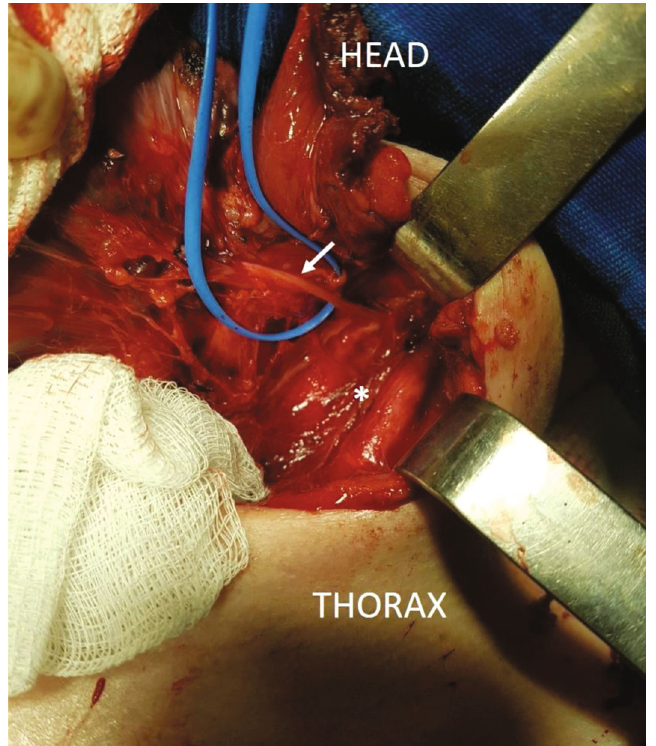
Figure 3: Dissection of the path of the left laryngeal nerve (arrow) until its emergence in the vagus nerve, in the dissected carotid sheath (asterisk). The left laryngeal nerve may be seen to follow a perpendicular path towards the thyroid (already resected in the photo above), as opposed to looping under the aortic arch. Table 1: Cases reported in the literature describing nonrecurrent inferior laryngeal nerve on the left.